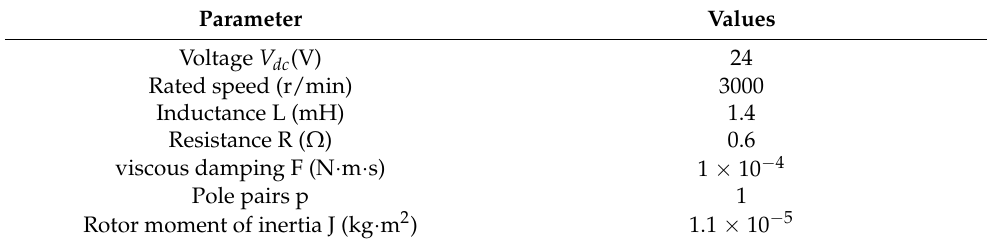
Table 1. PMSM parameters.